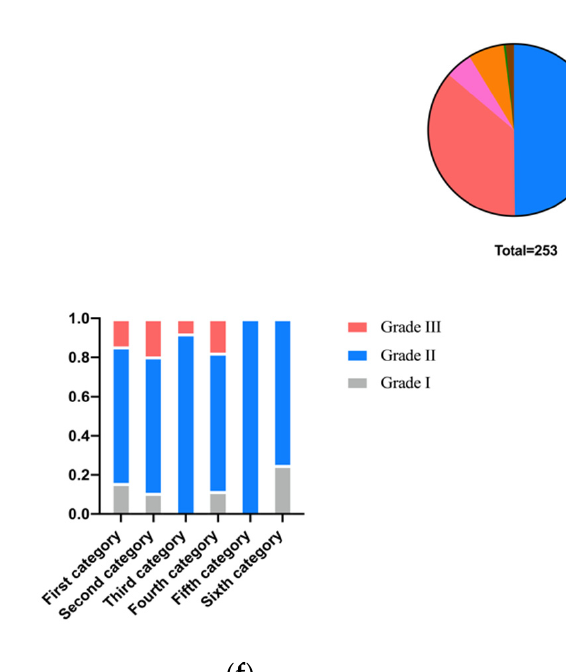
Figure 11. ( a ) Patients who like to drink carbonated drinks have a higher proportion of Grade III difficulty. ( b ) Patients who like sweets have a higher proportion of Grade III difficulty. ( c ) Patients